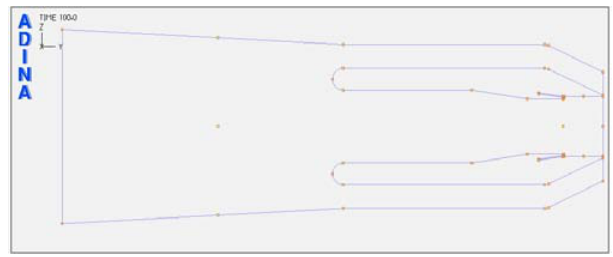
Fig 2. Flat model of geometric of injector